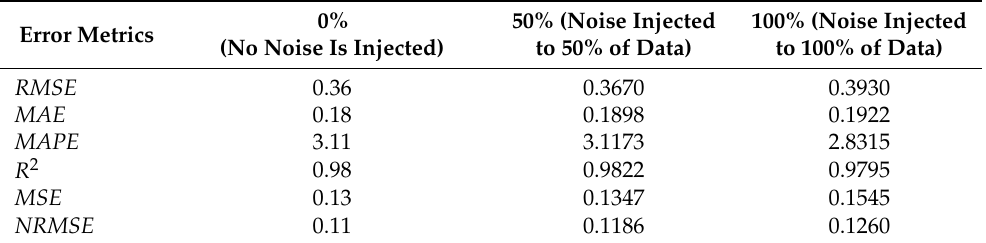
Table 7. Robustness Analysis of the proposed Multi-Step CNN Stacked LSTM Technique with 50 dB SNR.